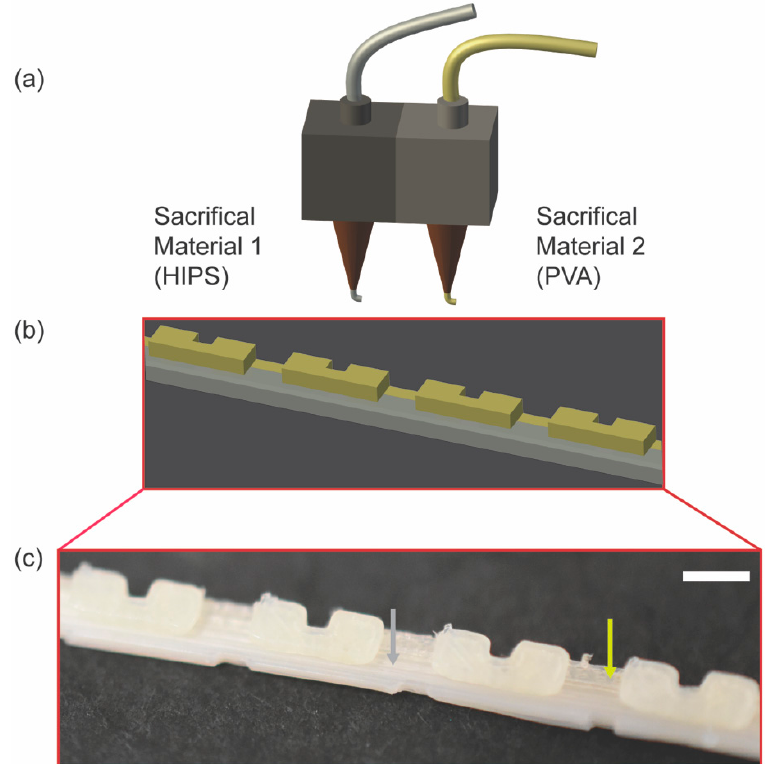
Figure 2. Schematics and optical images showing fabrication of dual sacrificial mold by dual extrusion printing using a FDM 3D printer. ( a ) Schematic of dual extruder installed on the 3D FDM printer dispensing HIPS as Sacrificial Material 1 from the left extruder and PVA as Sacrificial Material 2 from the right extruder; ( b ) A 3D model of a sacrificial mold with a serpentine pattern printed by dual extrusion of HIPS and PVA. The support structure shaded in grey was printed with HIPS and the channel structure shaded with yellow was printed with PVA; ( c ) Optical image of the printed model depicting deposition of HIPS (indicated with a grey arrow) and PVA (indicated with a yellow arrow). Scale bar = 2.0 mm.